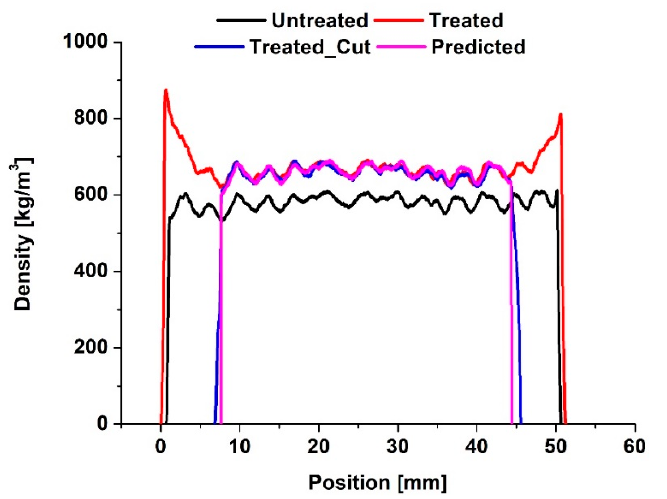
Figure 7. The density profiles of untreated ( black ), treated ( red ), treated with cut-off edges ( blue ) and predicted ( pink ) wood specimens ( WPG =